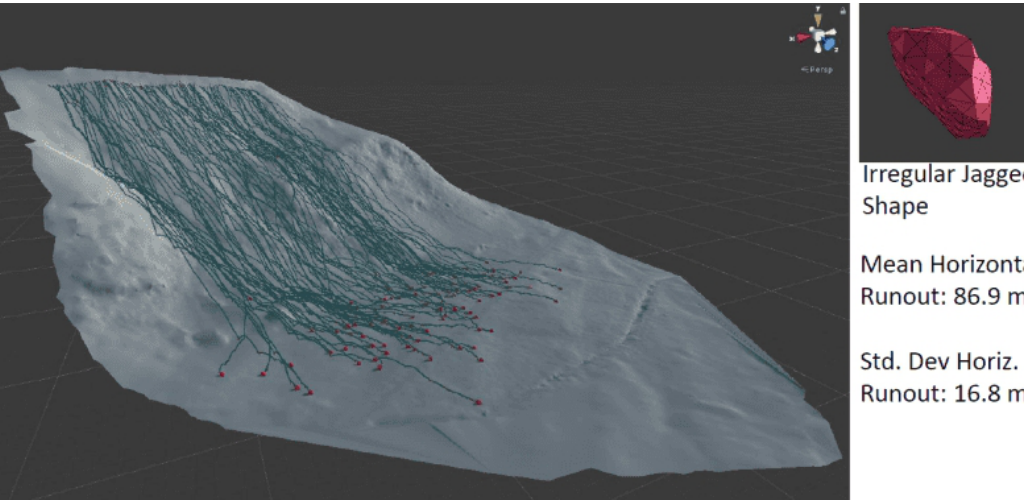
Figure 18. Rockfall simulation of the Oberalp test site using the Unity Rockfall Model as described in Sala et al. [35] (source: Zac Sala). The same simulation using an irregular round shape delivered a mean runout of